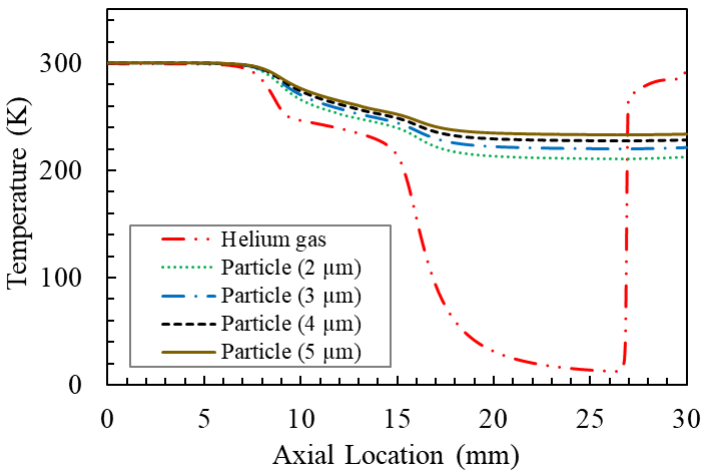
Figure 17. Effect of particle size on centerline particle temperature.